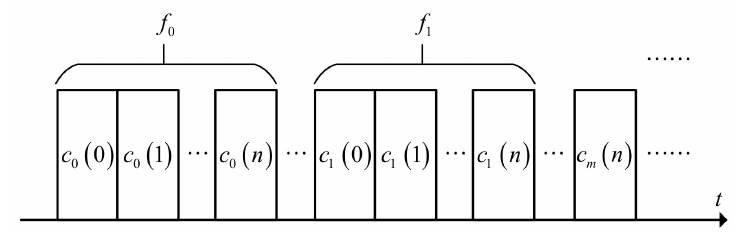
Figure 1. Schematic diagram of the proposed FSK-PSK